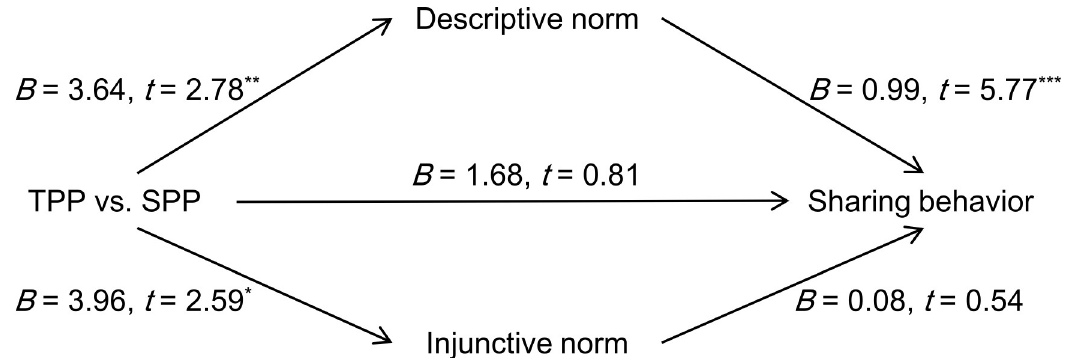
Fig 2. The influence of punishment source on observers’ sharing behaviors mediated by norm perceptions in Experiment 1 ( � p < 0.05, �� p < 0.01, ��� p <